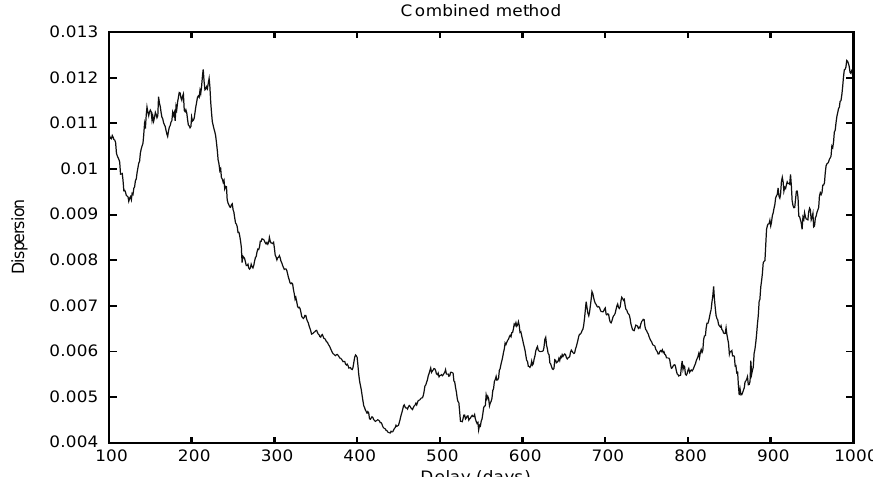
Fig. 2. The output curve of the combined method applied to the Vanderriest et al. (1989) data. Extrinsic variability ignored ( P = 0), delay estimate (cid:28) AB = 440